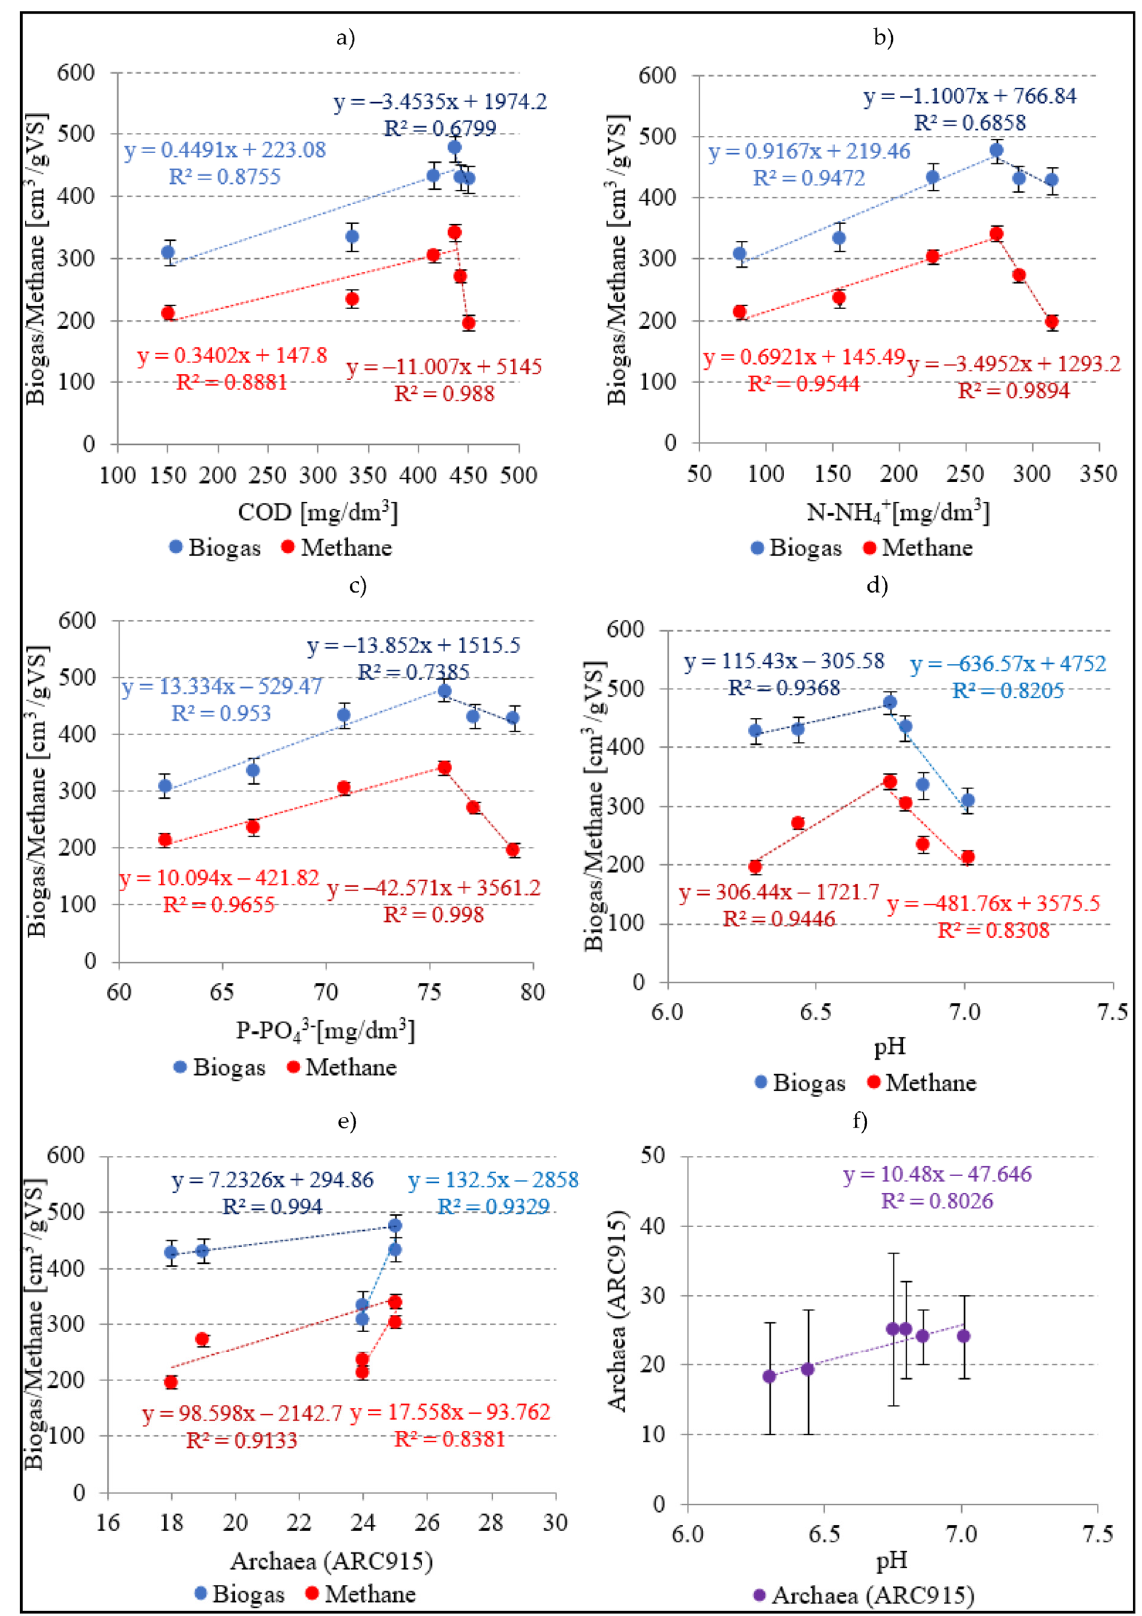
Figure 8. Correlations between: ( a ) COD, ( b ) N-NH 4 + , and ( c ) P-PO 4 3 − concentrations in the dissolved phase, ( d ) pH, ( e ) Archaea, and the yields of biogas and methane, as well as between ( f ) pH and